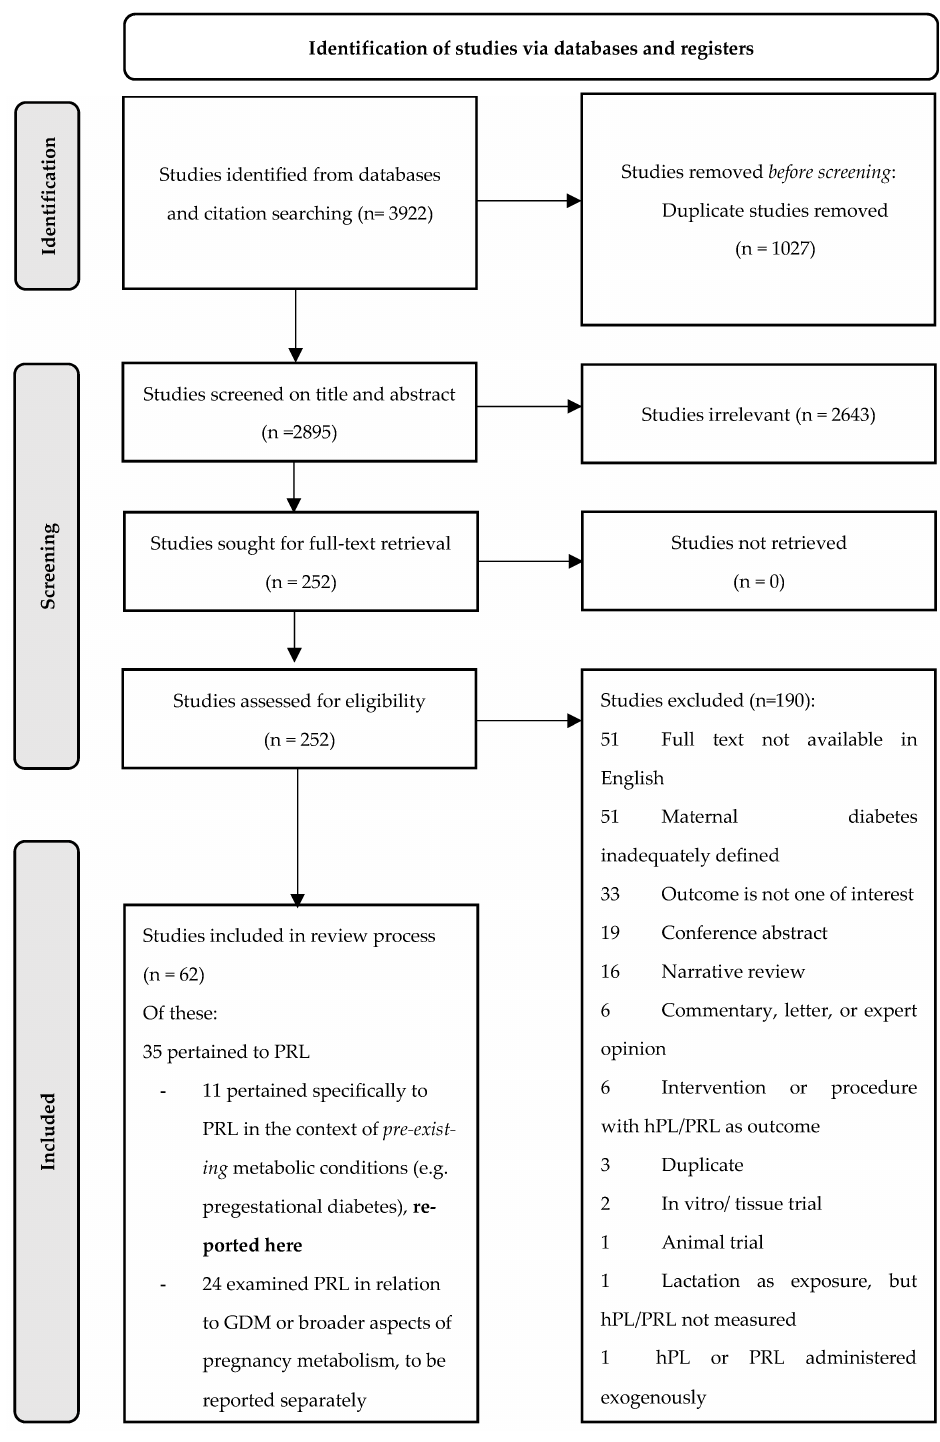
Figure 1. PRISMA flowchart